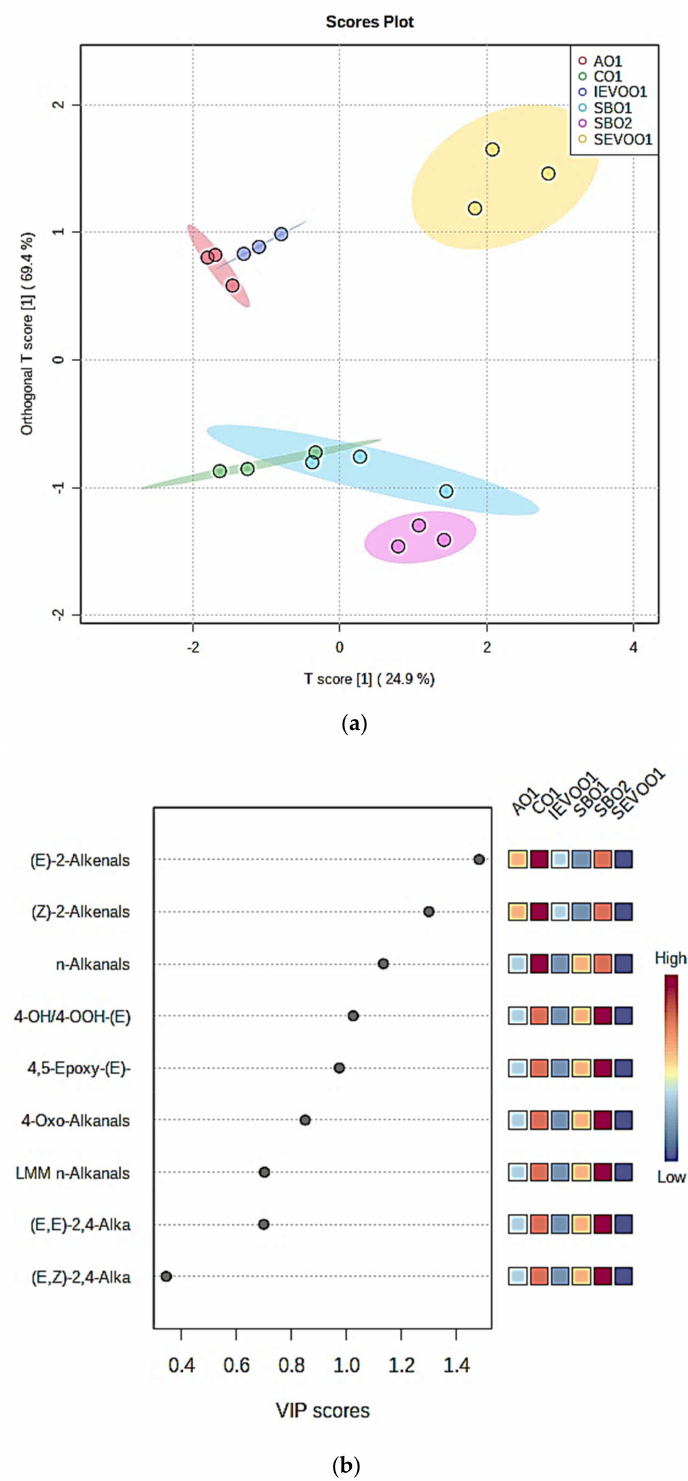
Figure 4. ( a ) OPLS-DA scores plot of orthogonal T score [1] versus T score [1], showing distinctions between patterns of aldehydic LOP concentrations generated in the oils tested at the 90 min LSSFE time-point. ( b ) Variable importance parameter (VIP) values for the OPLS-DA model applied in ( a ). Abbreviations, as in Section 2.1, with 4-OH/4-OOH-(E), 4,5-Epoxy-(E)-, (E,E)-2,4-Alka and (E,Z)- 2,4-Alka representing combined 4-hydroxy-/4-hydroperoxy-( E )-2-alkenals, 4,5-epoxy-( E )-2-alkenals, ( E,E )-2,4-alkadienals and ( E,Z )-2,4-alkadienals,